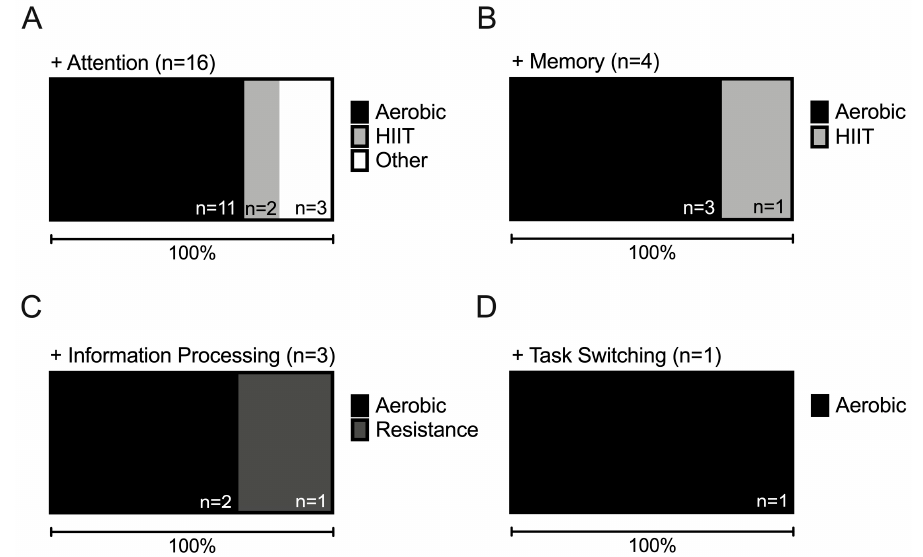
Aerobic, HIIT, Resistance and ‘Other’ exercise